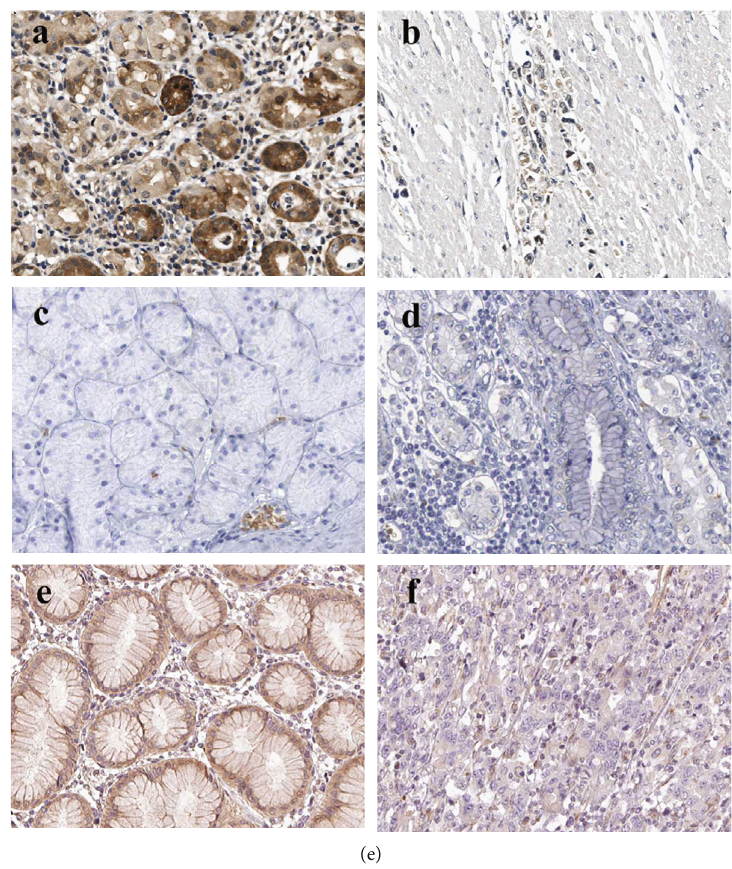
Figure 3: Inactivation of the TSPAN12 expression and TGF- β 1/SMAD4 pathway in gastric cancer. (a – c) TSPAN12, TGF- β 1, and SMAD4 expression was tested in gastric cancer and normal tissues utilizing western blot. (d) Representative images of western blots. (e) Immunohistochemistry results of (a, b) TSPAN12, (c, d) TGF- β 1, and (e, f) SMAD4 in gastric cancer and normal tissues. ∗∗∗∗ p < 0 : 0001